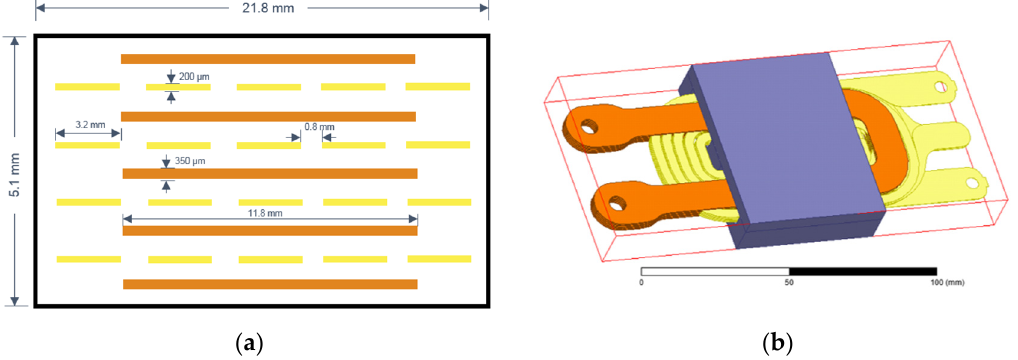
Figure 3. Planar prototype: ( a ) transformer’s window; ( b ) three-dimensional finite element analysis (3-D FEA) model.